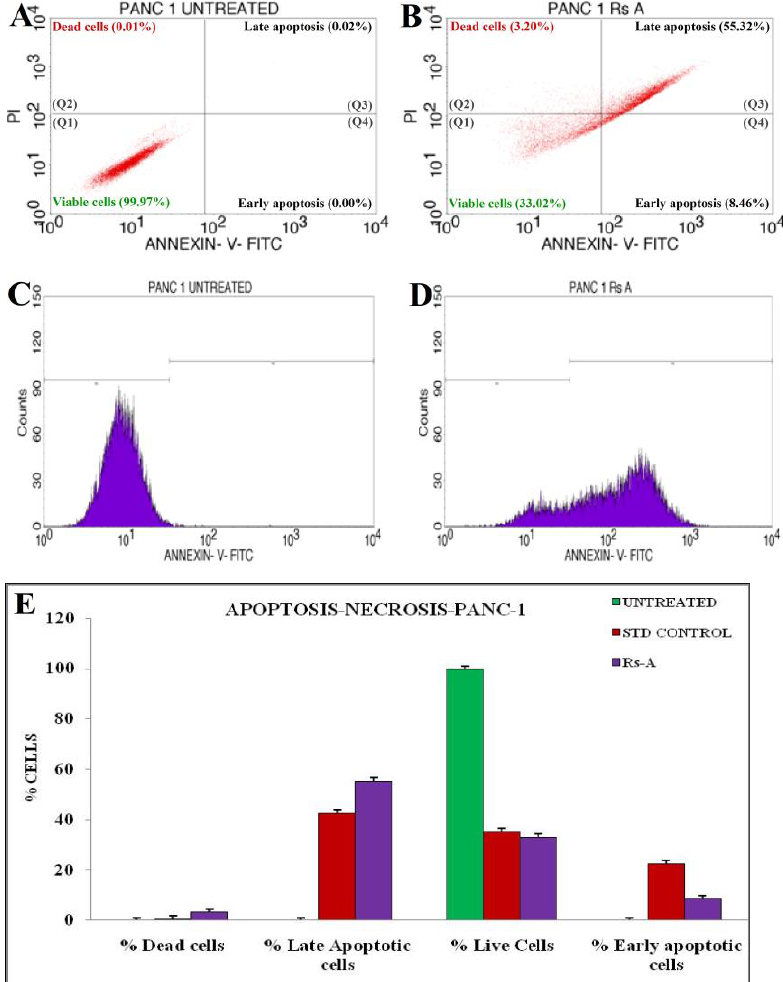
Figure 11. Quadrangular plots showing the flow cytometric cell viability test of PANC-1 cells after treatment with an IC 50 concentration of synthesized RsFb-AgNPs: ( A ) untreated, ( B ) treated cells with an IC 50 concentration of synthesized RsFb-AgNPs, ( C ) cell cycle analysis of untreated control sample, and ( D ) treated cells with an IC 50 concentration of synthesized RsFb-AgNPs. ( E ) Graph showing the comparative percentage of apoptotic rate in standard drug, untreated, and treated cells.